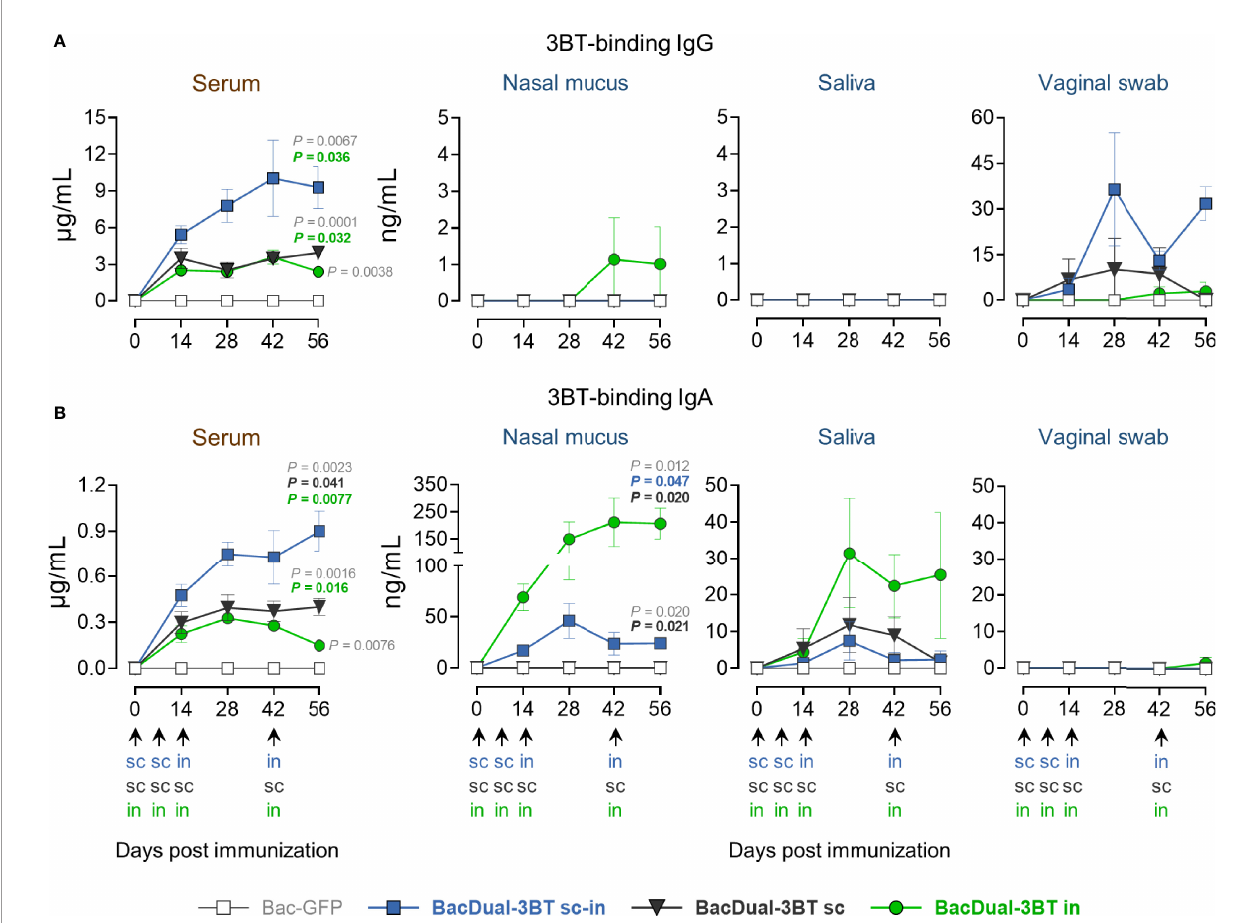
FIGURE 4 | BacDual-3BT-immunized animals generated different quantities of 3BT-binding IgG and IgA in serum and mucosal fl uids, depending on the inoculation route. Mini-pigs were vaccinated with 5 x 10 8 PFU of recombinant baculoviruses in the fi rst two doses, regardless of the route, and 1 x 10 9 PFU in the last two doses. Kinetics of serum and mucosal 3BT-binding IgG (A) and IgA (B) , assayed by quantitative ELISA using E. coli expressed s3BT. Differences in the levels of antibodies among the groups were analyzed utilizing two-way ANOVA with the Geisser-Greenhouse correction, followed by Dunnett´s (comparison with the control group) and Tukey´s (comparison among the groups) multiple comparisons. Graph scales are different and error bars represent SEM. P values ≤ 0.05 are indicated for day 56